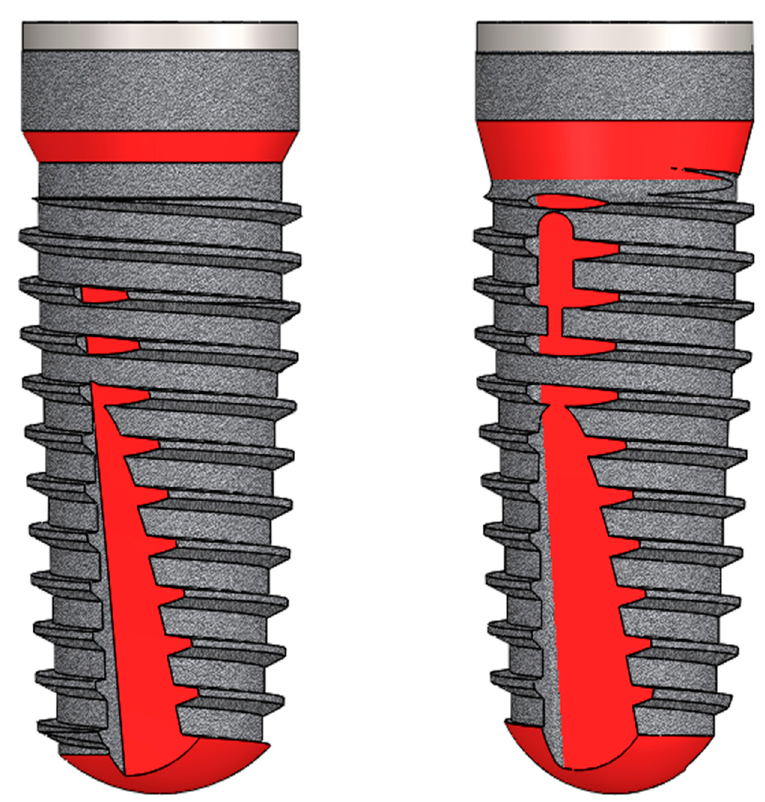
Figure 1. Schematic illustrations of the two implant systems (Camlog Screw-Line, Promote ® plus) showing the J-line ( left ) and the K-line ( right ). Changes in macrogeometry are marked in red (with kind approval: Camlog Biotechnologies AG, Basel, Switzerland).